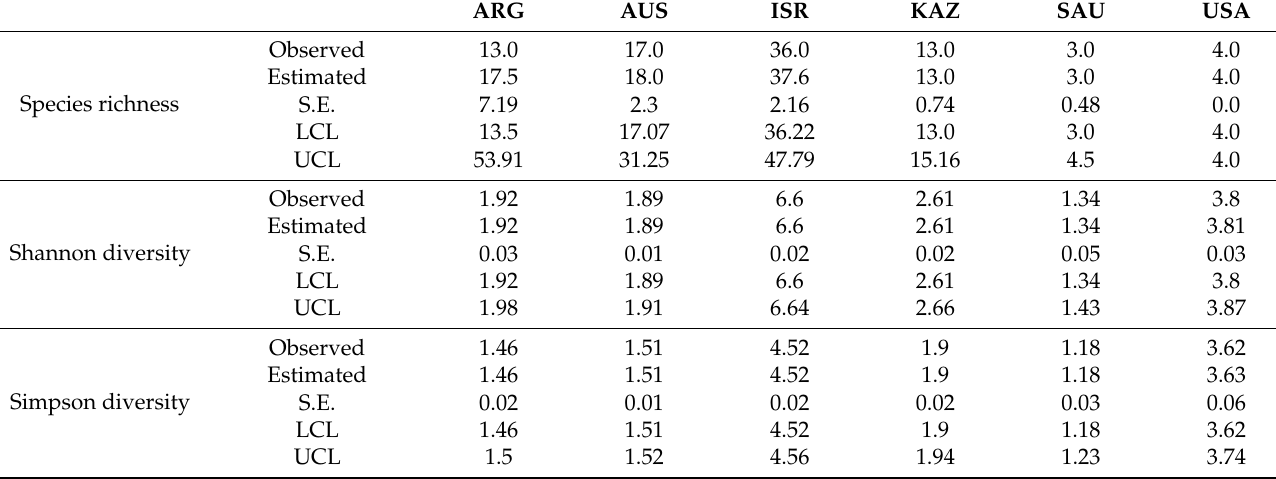
Table 3. AM fungal virtual taxa (VT) diversity at study sites—ARG, AUS, ISR, KAZ, SAU and USA. Observed richness and extrapolated values of richness, Shannon and Simpson diversity are given. Extrapolation was implemented in the iNEXT software [62]. Standard error (S.E.), lower confidence limits (LCL) and upper confidence limits